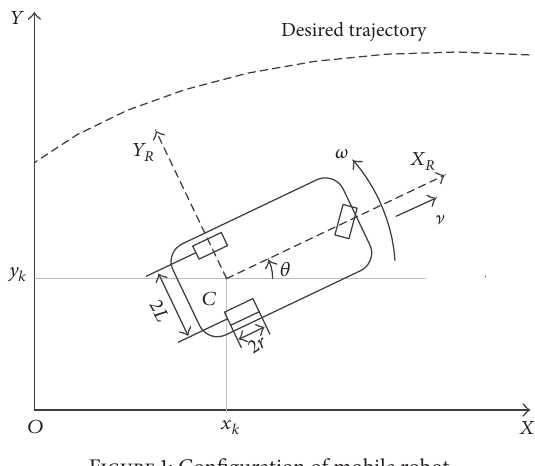
Figure 1: Configuration of mobile